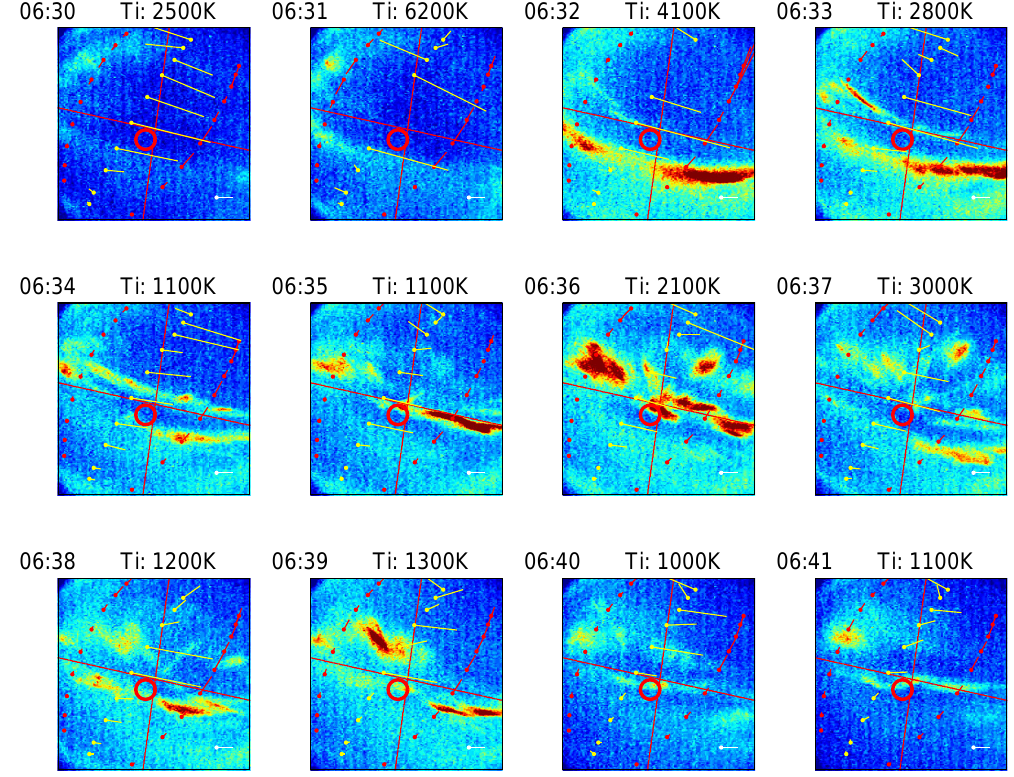
Fig. 7. All-sky images integrated to 1-min time resolution. The x and y axis show pixel number. The ESR field-of-view at 150km is in the center of the red circle. Magnetic meridional and zonal lines are indicated by red lines. Yellow lines starting from a dot indicate the EISCAT CP4 beam-swing derived velocity vectors. The CP4 line-of-sight velocities are shown as red lines originating from dots along the radar beam projection. A white line starting from a dot indicates the length corresponding to 1km/s. The time of observation and ESR ion temperature are indicated above each